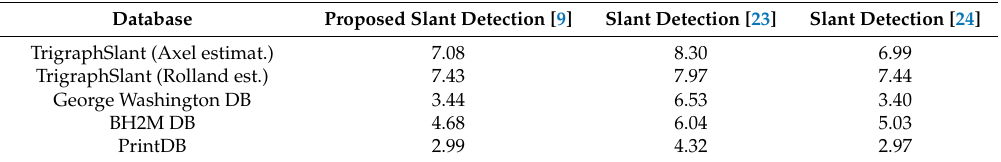
Table 1. Experimental